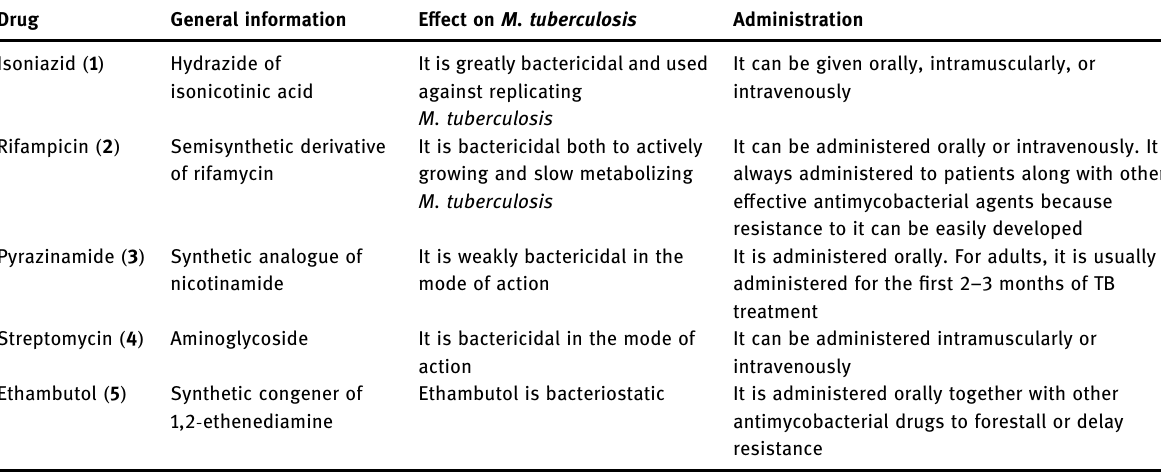
Table 1: Characteristics of fi rst - line antituberculosis drugs